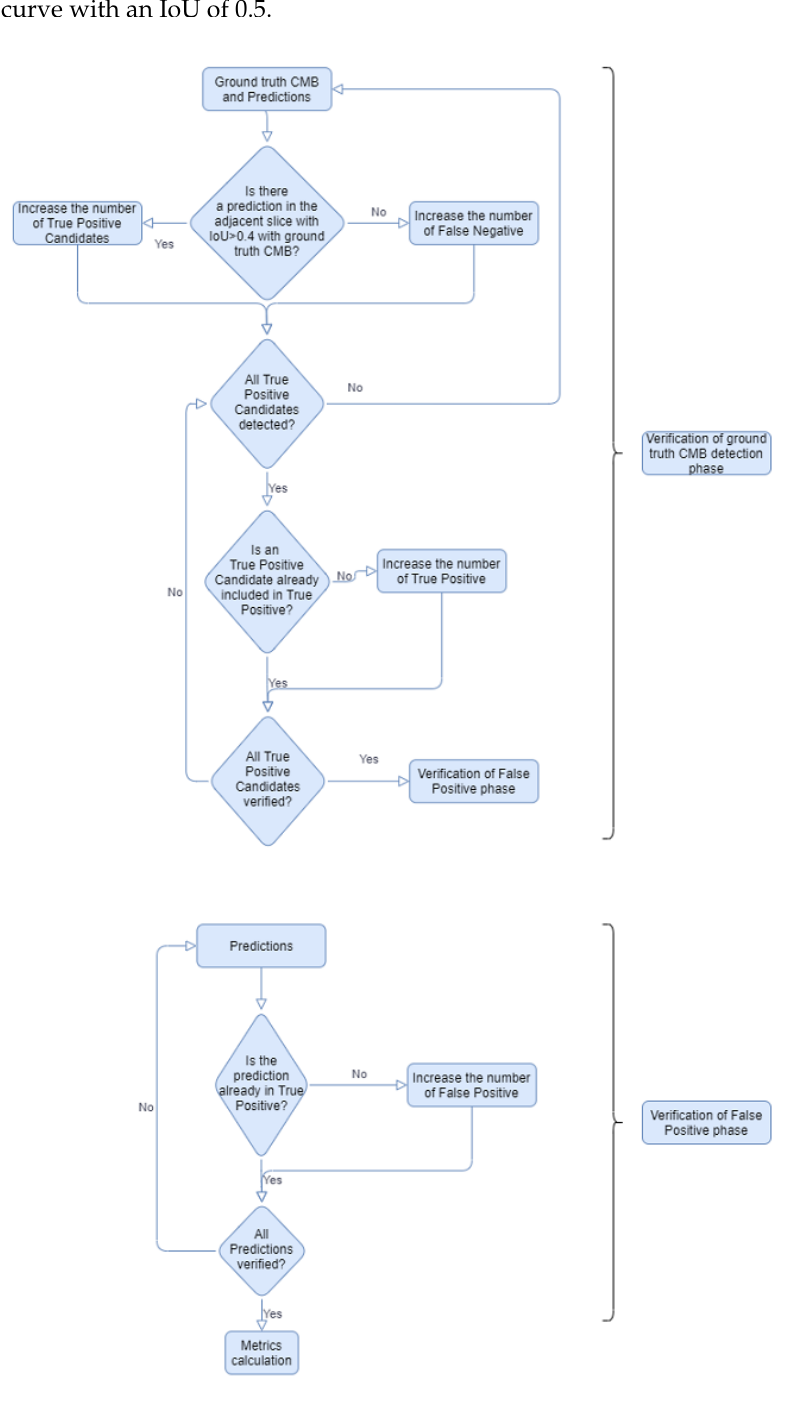
Figure 3. The flowchart illustrating the predictions post-processing stage. We used k-fold cross-validation, with 5 folds. The exact number of subjects and microbleeds in each fold is presented in Table